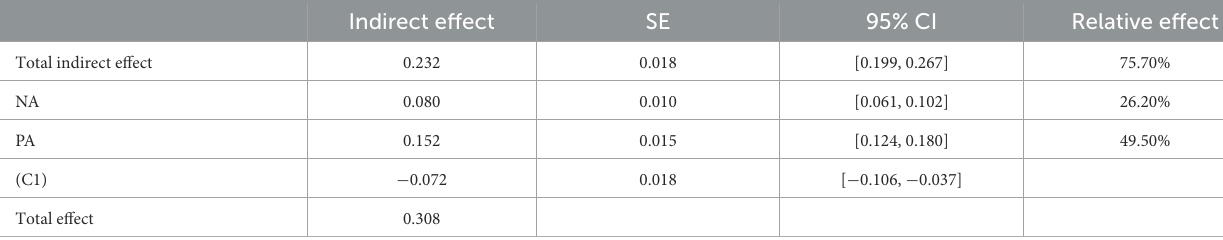
TABLE 4 Mediating effect test.